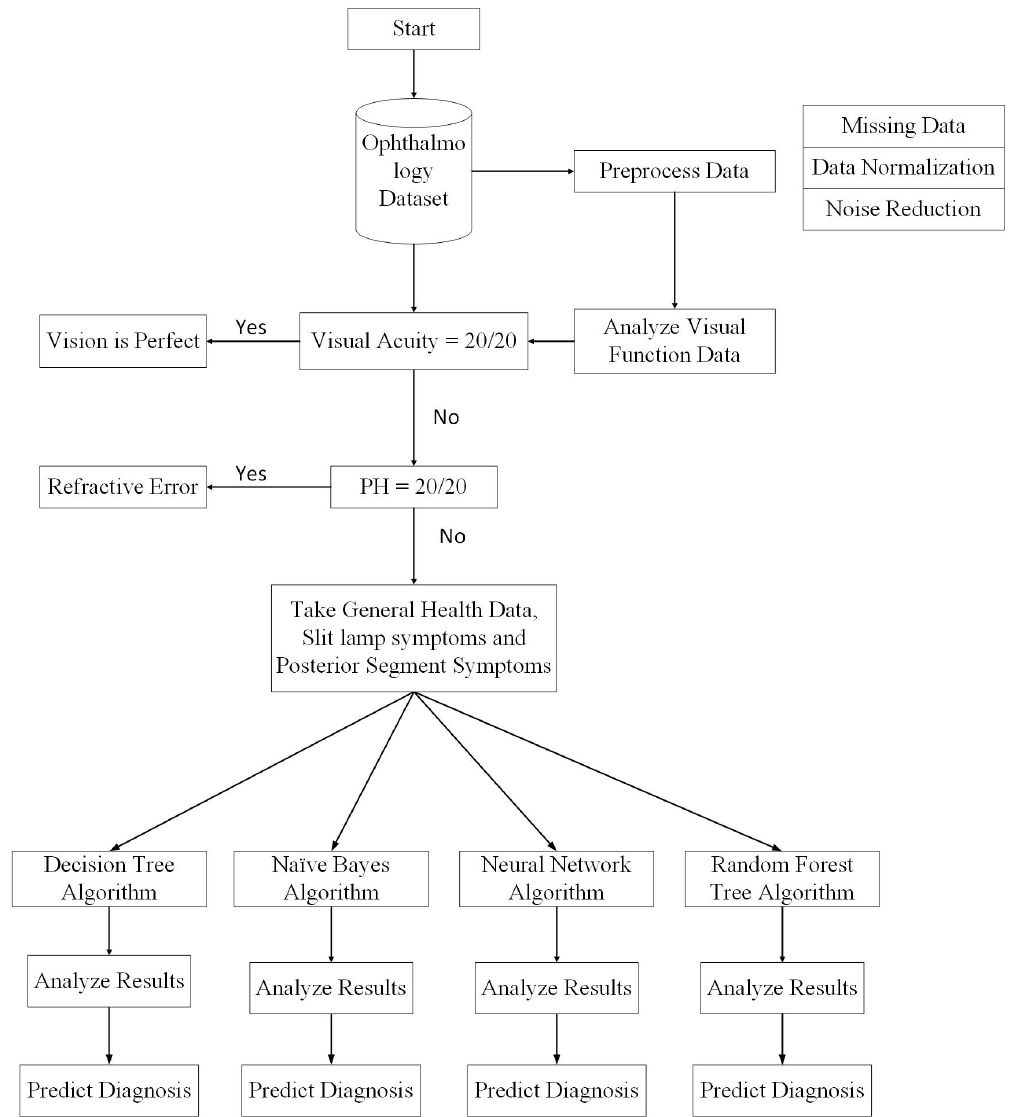
Figure 5. Framework for the prediction of eye diseases: Data are collected and its analysis is used for disease prediction by comparison with expert diagnosis for correct classification. Four different algorithms were used to authenticate the predicted